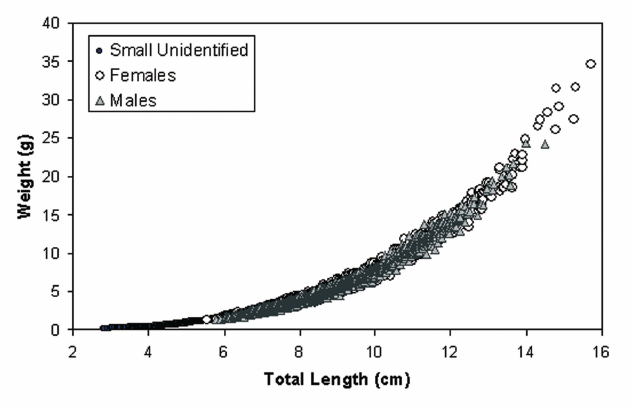
Fig. 1 . Length/weight relationship of the silverside Atherinella brasiliensis in Tramandaí Estuary, Southern